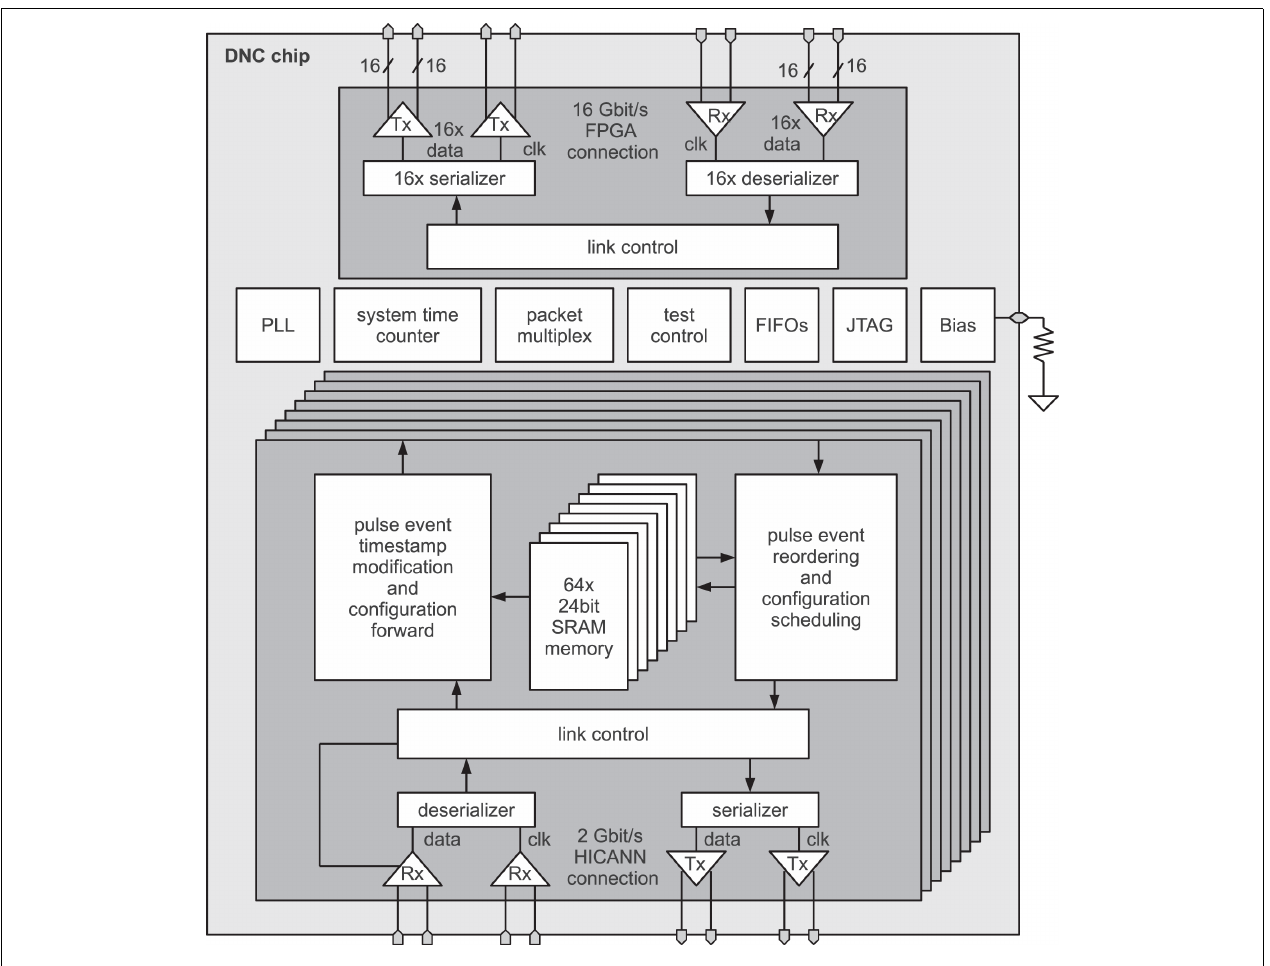
FIGURE 5 | Block diagram of DNC with its eight HICANN interfaces and the FPGA connection (Scholze et al.,